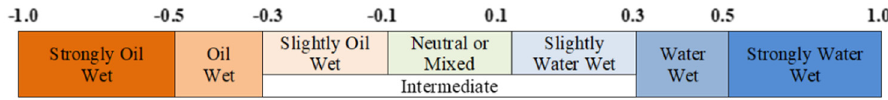
Figure 3. Schematic diagram of the core flooding system.